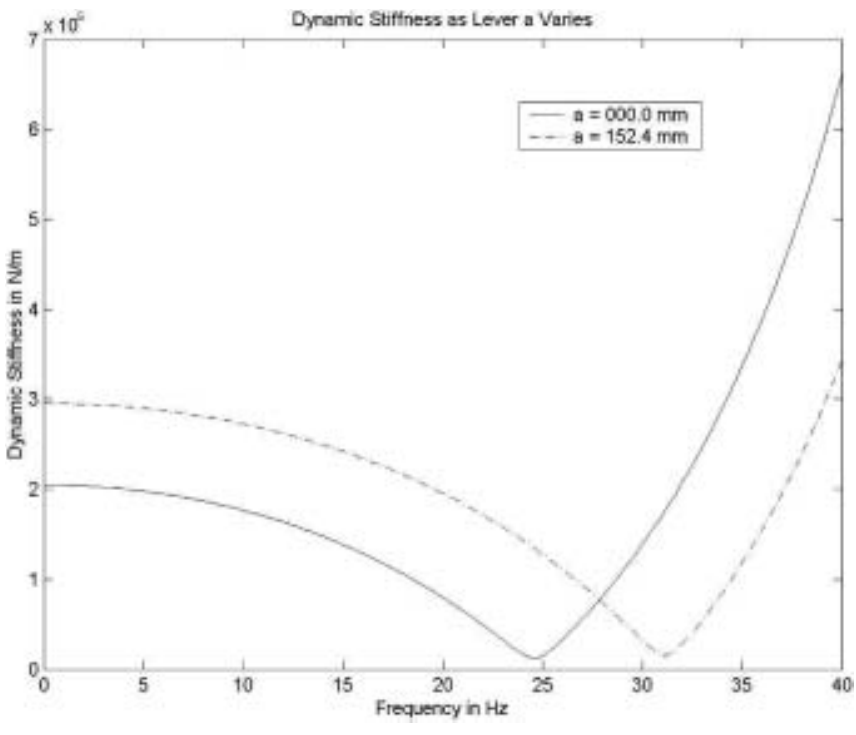
Fig. 12. Dynamic Stiffness versus Frequency with K = 7004 N/m (40